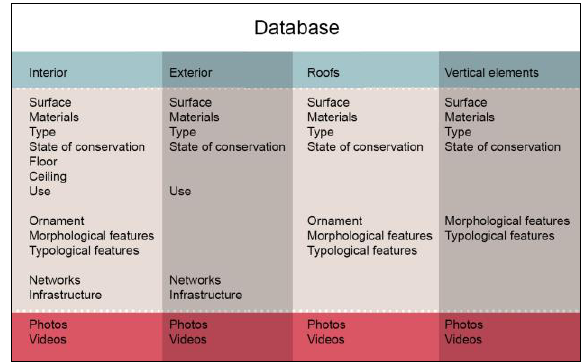
Figure 14 . Structure of the database.